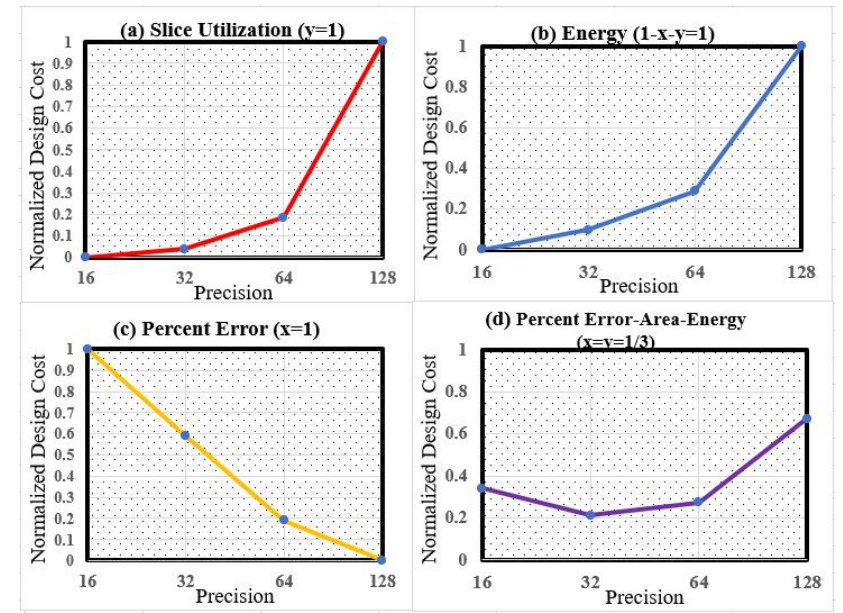
Figure 14. Normalized accuracy–area–energy